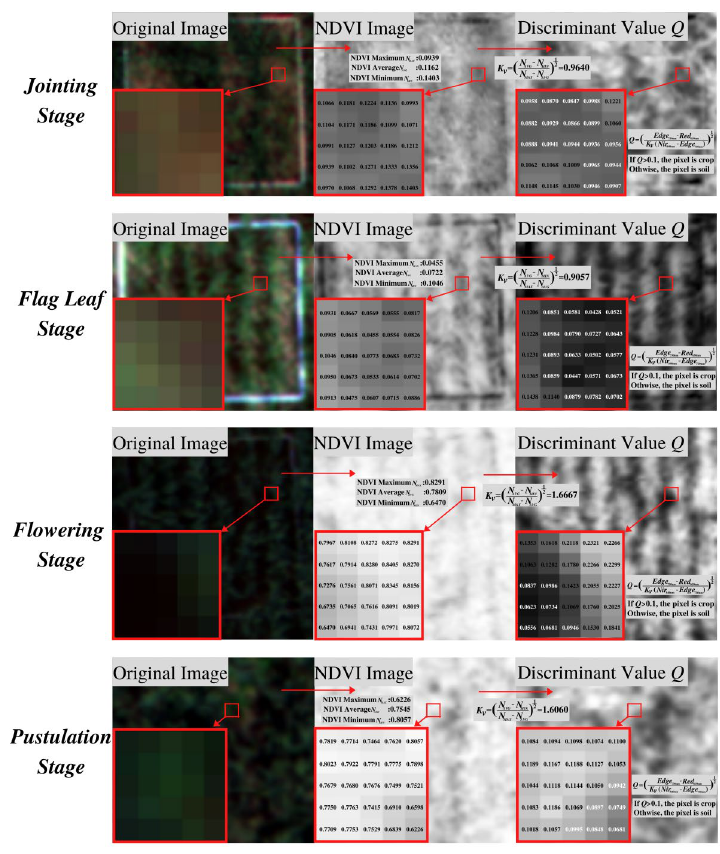
Figure 3. Accurate segmentation of crop and soil pixels.